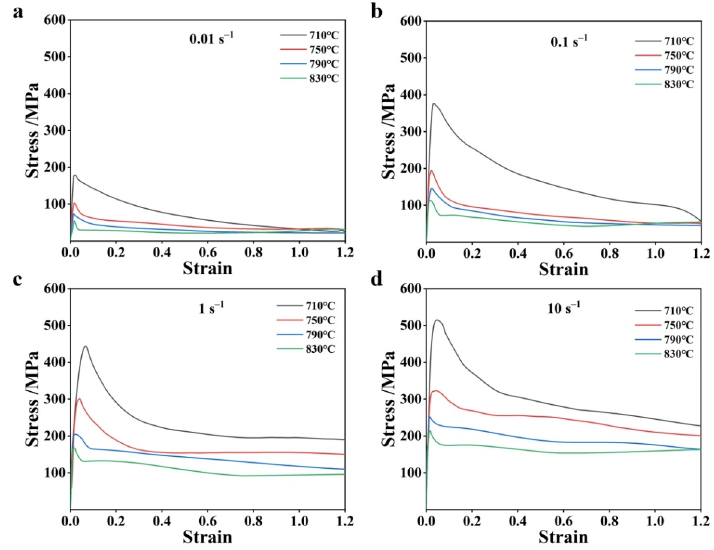
Figure 1. Flow stress–strain curves of Ti15Zr5Cu alloy under a constant strain rate and different temperatures. ( a ) 0.01 s − 1 ; ( b ) 0.1 s − 1 ; ( c ) 1 s − 1 ; ( d ) 10 s − 1.